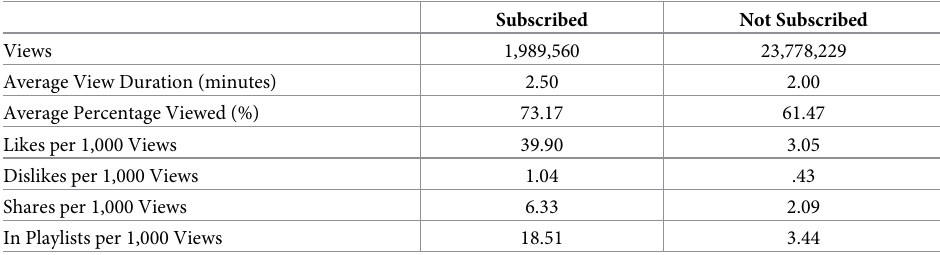
Table 2. User engagement by subscription